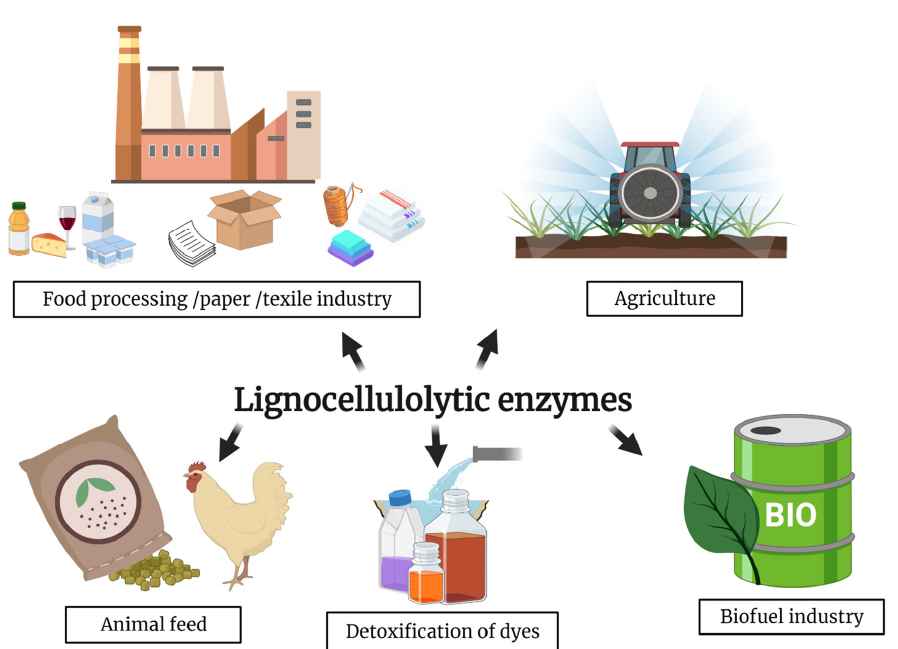
Figure 4. Industrial applications of lignocellulolytic enzymes. In food processes cellulases and xylanases are employed to improve the shelf life of dairy products and to hydrolyze monosaccharides in milk processing; they are also used in winery industries and to decrease viscosity of fruit juice. Also, laccases are used to increase quality of beverages and food, for example eliminating toxic substances. In pulp/paper industry laccases and xylanases enhance pulp bleaching for paper manufacturing, and cellulases improve flexibility and softness of fibers. Lignocellulolytic enzymes can be employed for improving nutrient digestibility of animal feeds, for enhancing color and surface brightness of fabric in textile industry, for textile dye bleaching, for synthesis of complex polymers. In agriculture, they are involved in fruit ripening and defense mechanisms against insects. Laccases are employed in wastewater treatment of colored waters. Lignocellulolytic enzymes are used in biorefinery systems to produce biofuels [103,127,128] (Created with BioRender.com (accessed on 20 January